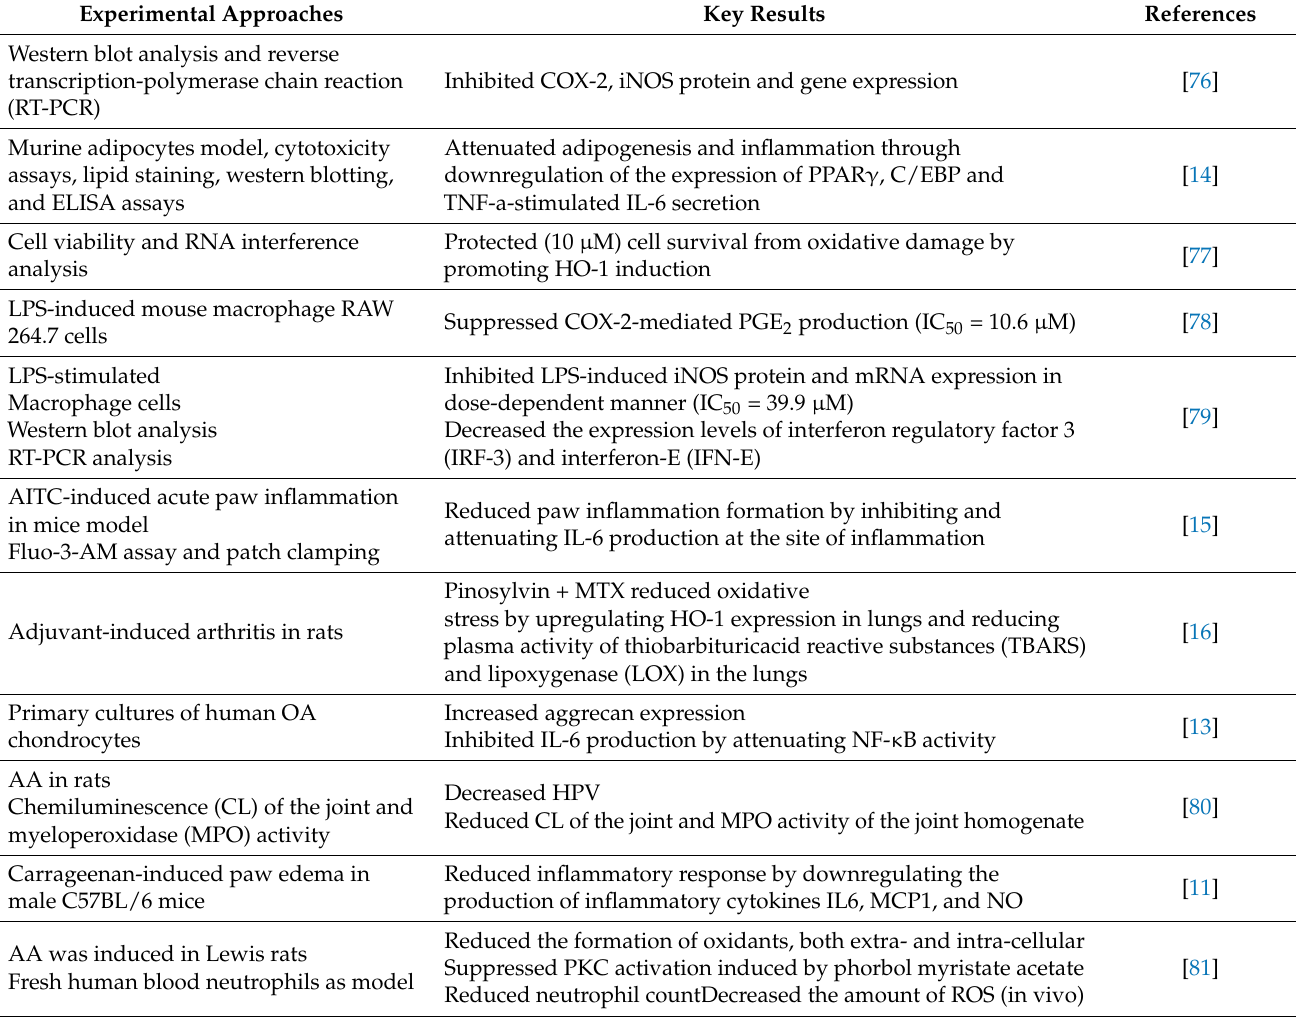
Table 2. Anti-inflammatory effects of